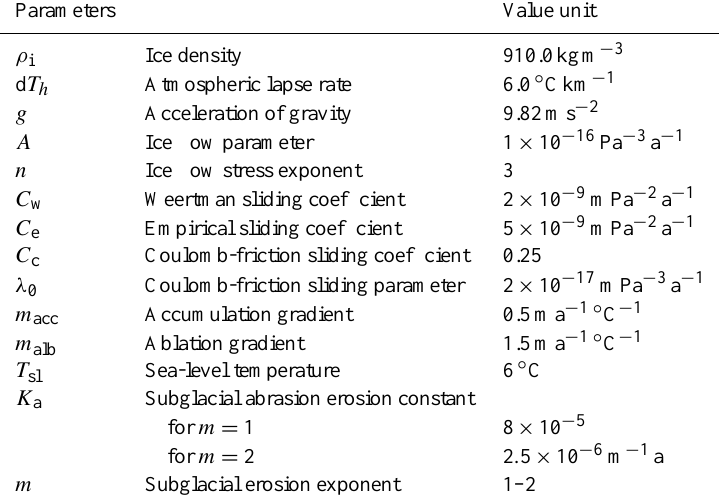
Table 1. Model parameters used for all